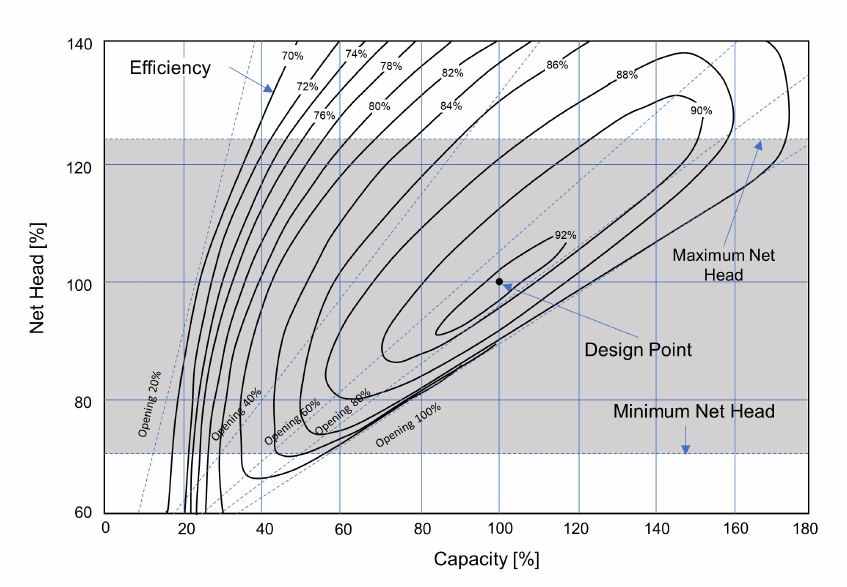
Figure A2. Performance curves of a Francis type hydraulic turbine. Adapted from